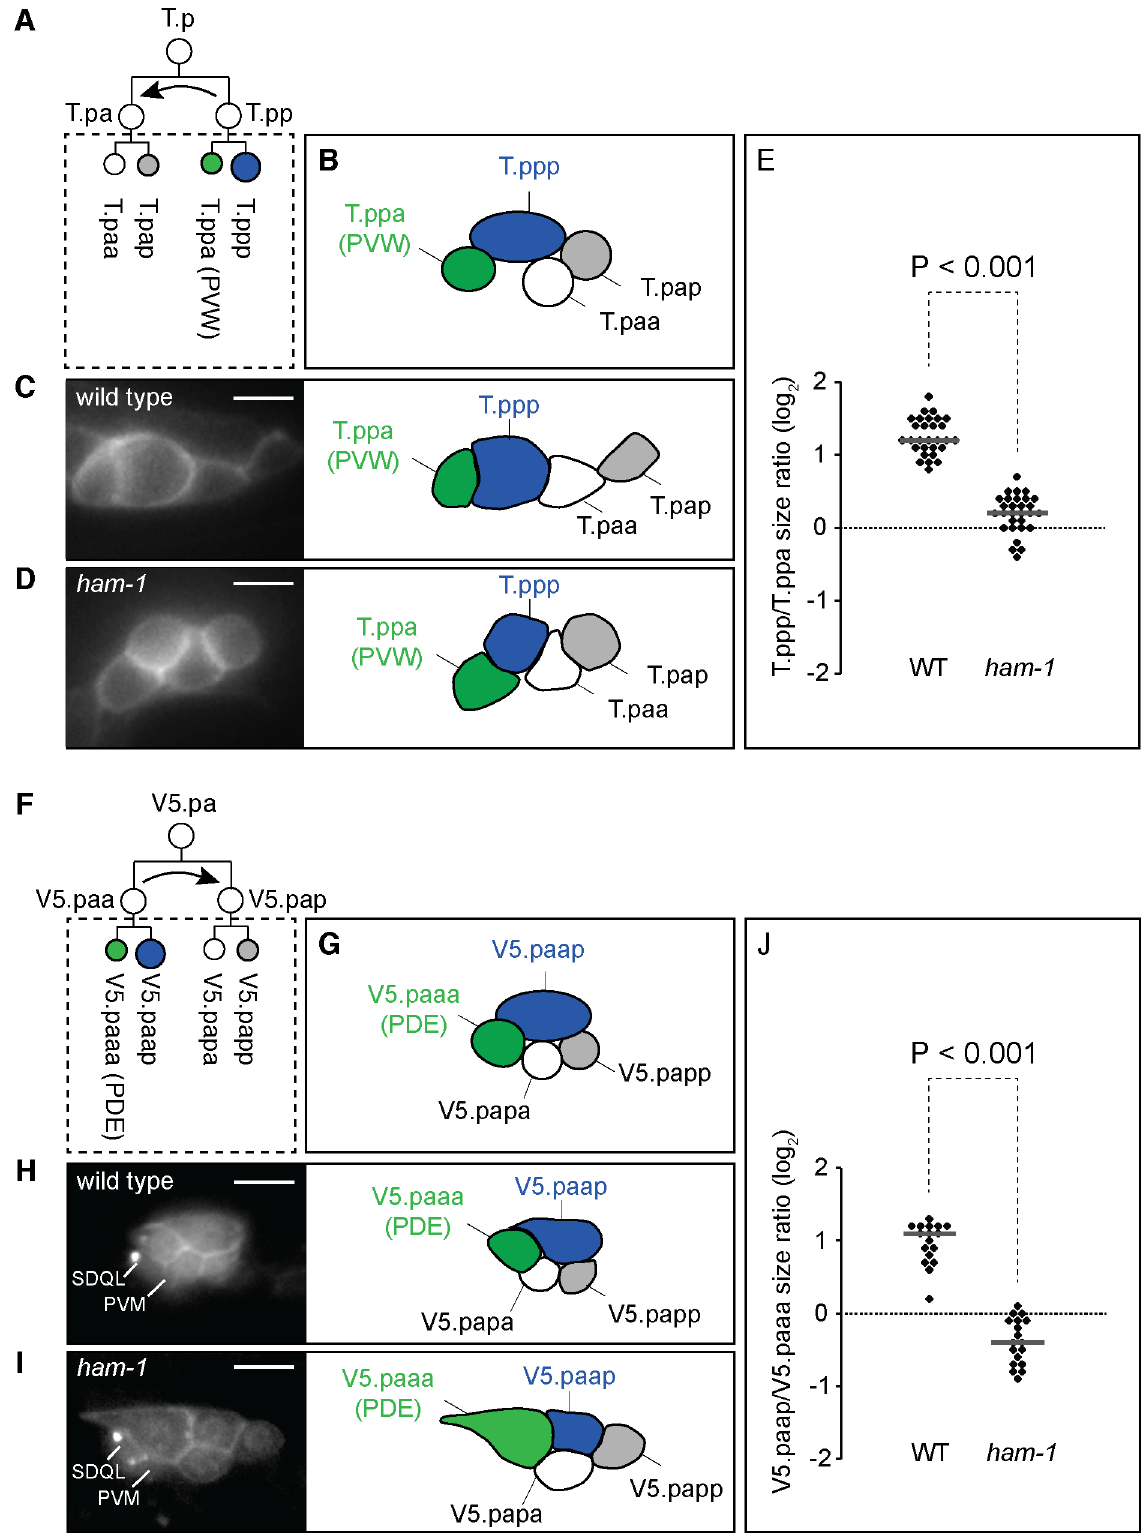
Fig 3. Daughter cells size asymmetry (DCSA) defects in the ham-1 mutant T.pp and V5.paa divisions. (A) Schematic representation of the divisions in the T.p lineage. The T.pp division produces daughter cells of different fates and sizes, whereas the T.pa division produces daughter